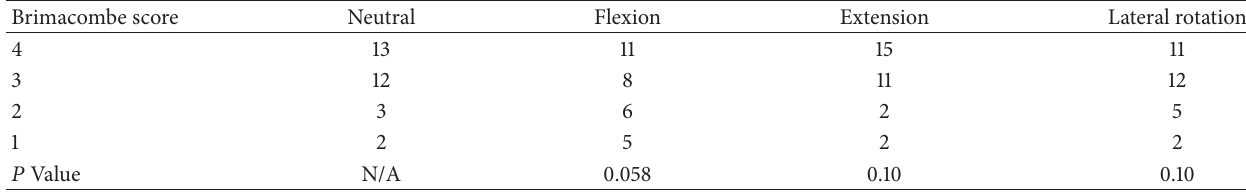
Table 3: Fibreoptic view of the glottis with ProSeal